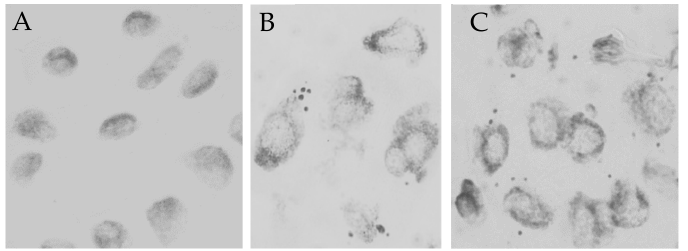
Figure 3. Cytological effects of MH in root cells of barley seedlings of the cv. “Sebastian” and hvatr.g mutant. ( A ) Control nuclei without micronuclei; ( B , C ) Nuclei with micronuclei after MH treatment: ( B ) cv. “Sebastian” ( C ) hvatr.g mutant. Bar 20 µm.